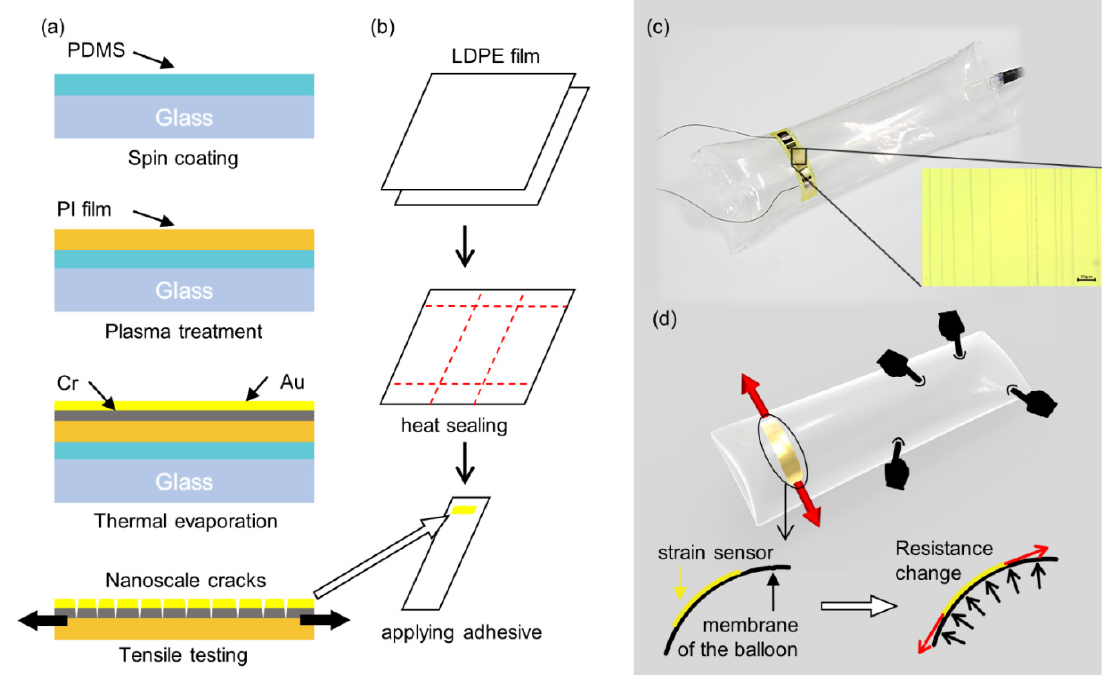
Figure 2. Schematic illustration of a fabrication process for the balloon sensor; ( a ) the Fabrication process for the crack-based strain sensor; ( b ) prepare two sheets of polymer film (LDPE), apply heat by a soldering iron or a heat sealer (200 °C) to the desired parts and cut out the rest. Attach the highly sensitive strain sensor to the inflatable; ( c ) a photograph of the prototype of the fabricated balloon sensor with the microscopic image of the strain sensor; ( d ) schematic design of the sensor illustrating its sensing mechanism.